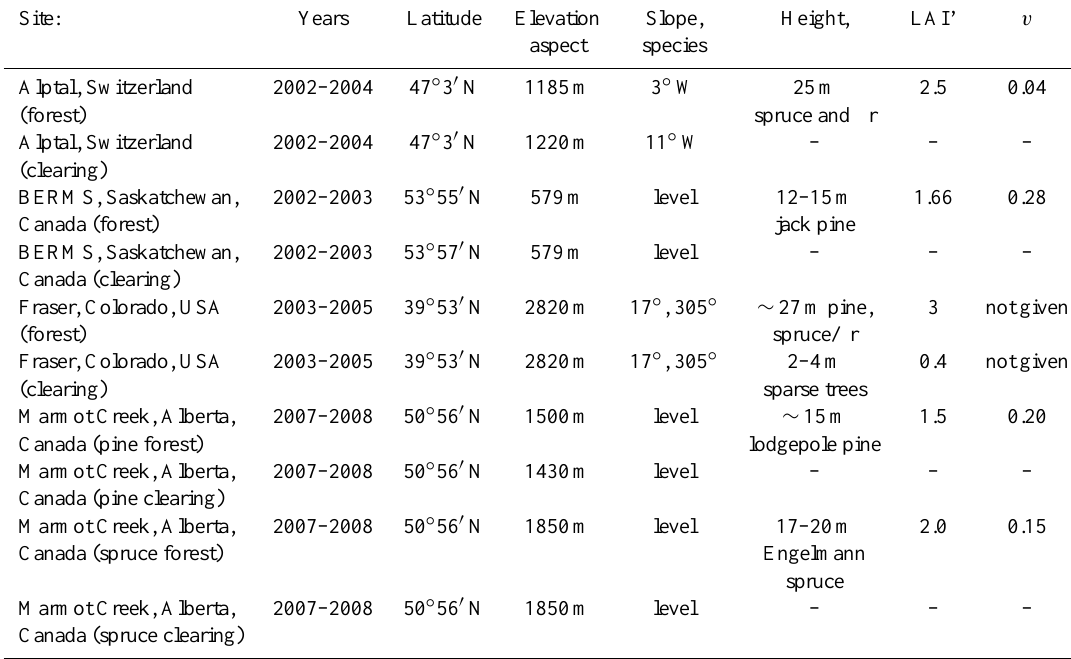
Table 1. Location, topography, and forest cover descriptions of paired clearing and forest sites used in simulations of snow accumulation and melt.